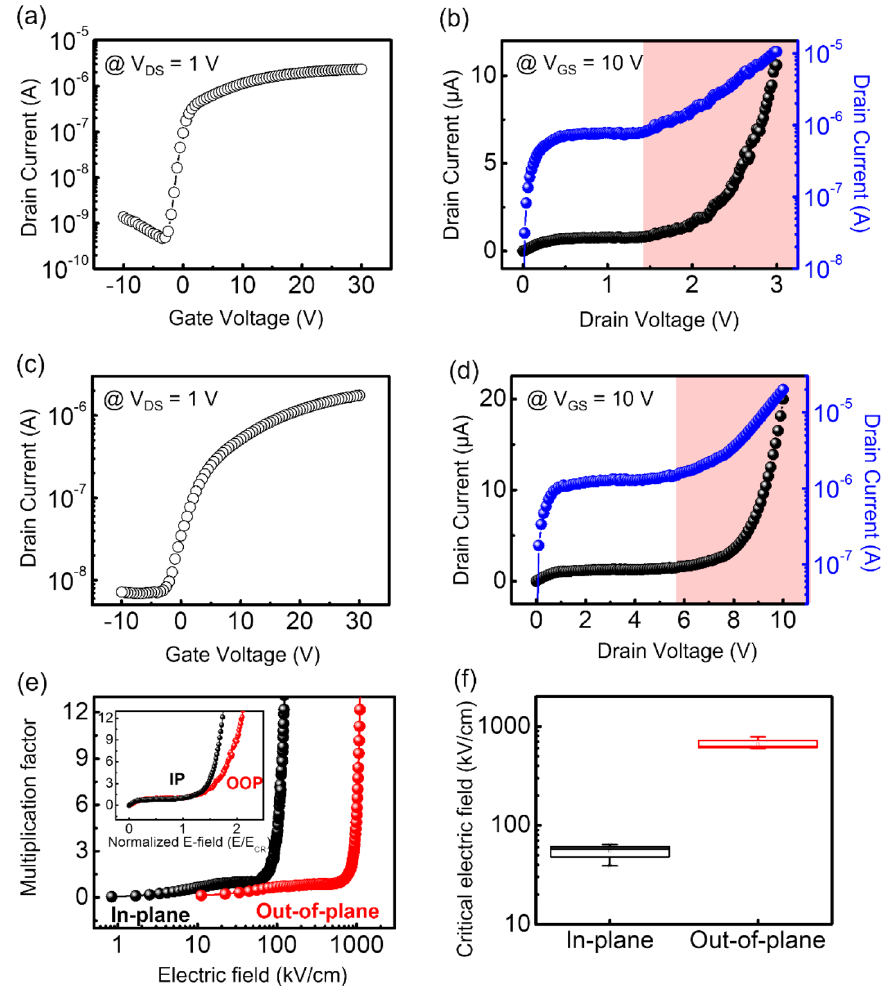
Fig. 2 Impact ionization characteristics for different carrier transport directions. a Representative transfer curve of the lateral FET with a 240 nm WSe 2 channel. b Output characteristics of the in-plane direction which shows impact ionization occurring above 1.4 V. c Representative transfer curve of the vertical FET employing 90 nm thick WSe 2 . d I DS –V DS characteristics of the out-of-plane direction exhibiting impact ionization occurring above 5.7 V. e Calculated multiplication factors for each direction as a function of the electric field. For impact ionization to occur in the out-of-plane direction, an electric field that is approximately ten times larger than that of the in-plane is required. (Inset: multiplication factors as a function of the electric field, normalized by the E CR .) f Distributions of the critical electric fields in tens of